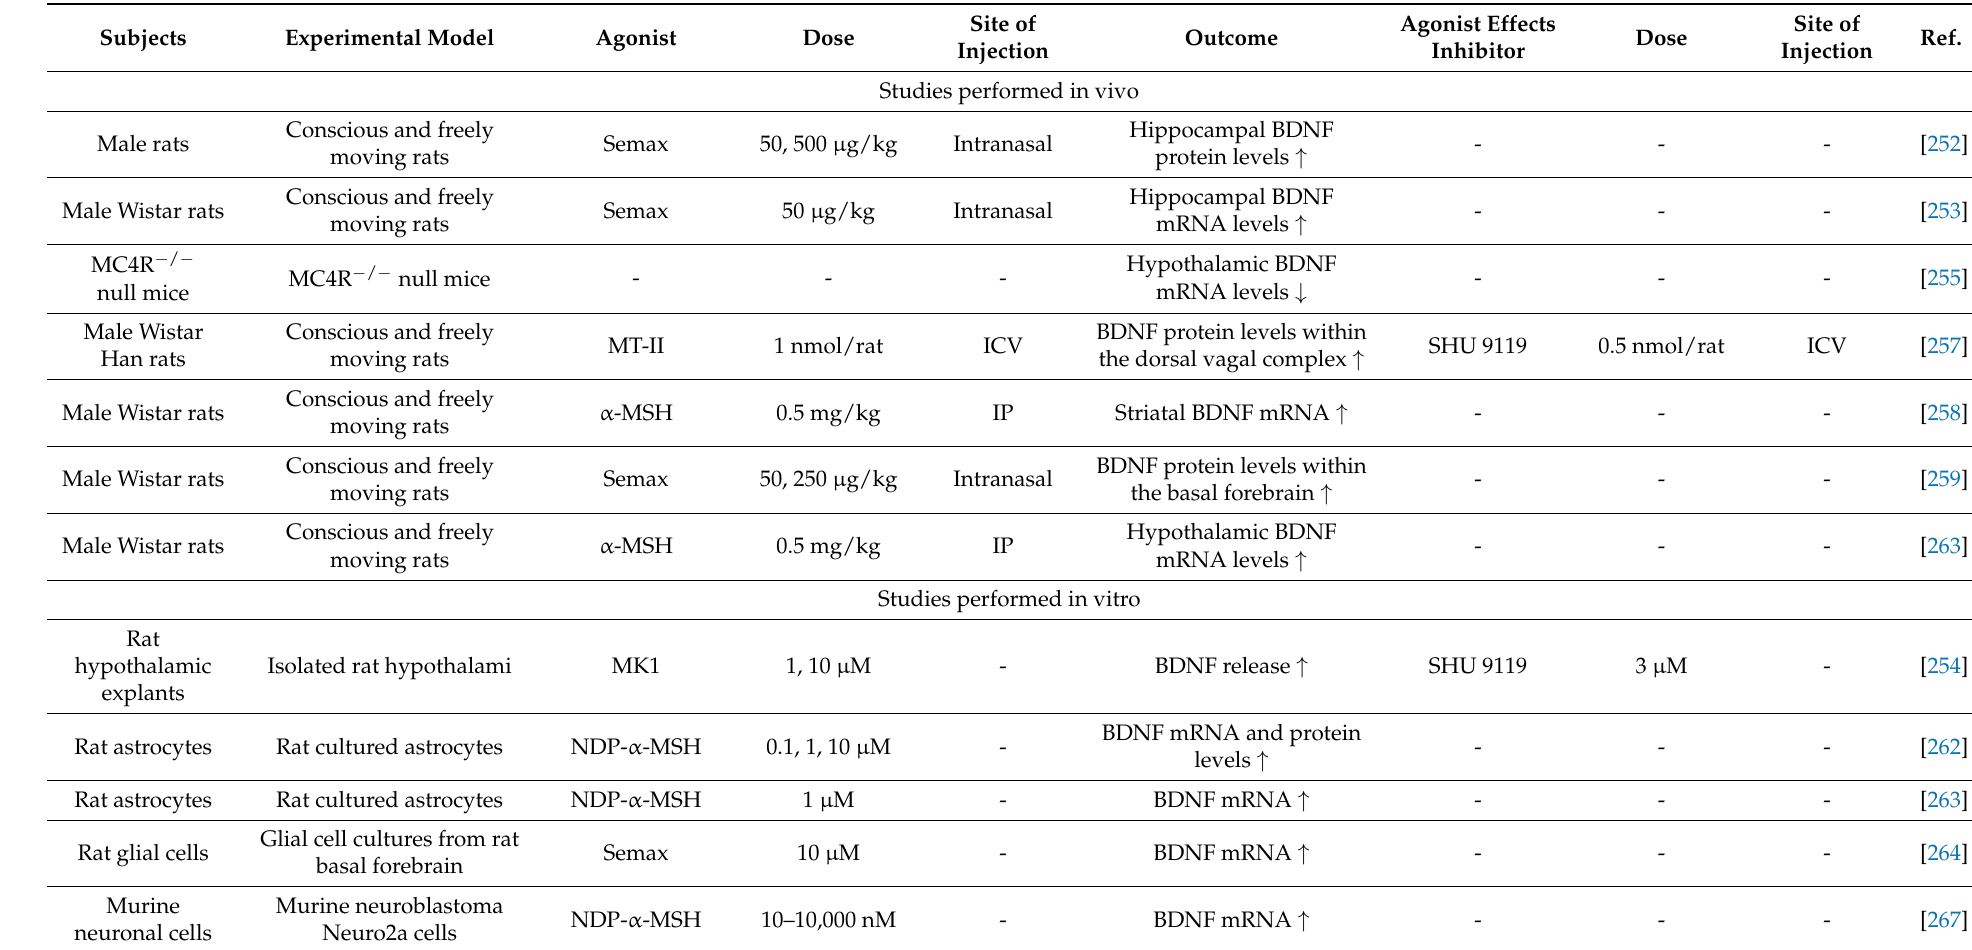
Table 5. A summary of the effects of melanocortin agonists on BDNF mRNA and protein